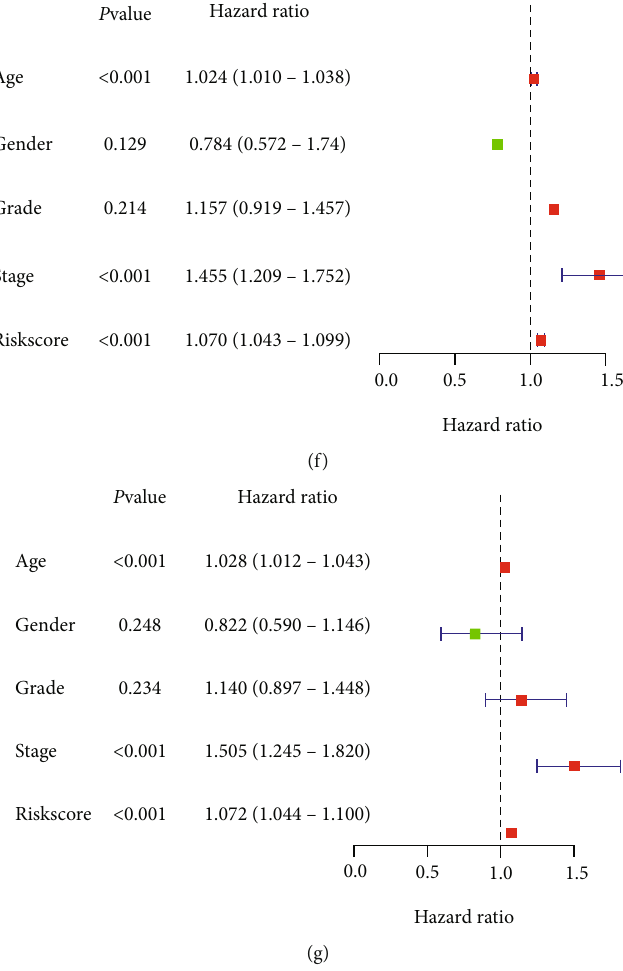
Figure 4: Con fi rmation of RMA-AS_Score prognostic signature. (a) LASSO regression analysis was performed for the RMA-AS events. (b) Distribution of risk score in RMA-AS_Score signature. (c) The survival status of HNSCC patients. (d) The results of Kaplan-Meier curve. (e) Heatmap of RMA-AS event PSI value. (f) The results of univariate Cox regression analysis. (g) The results of multivariate Cox regression